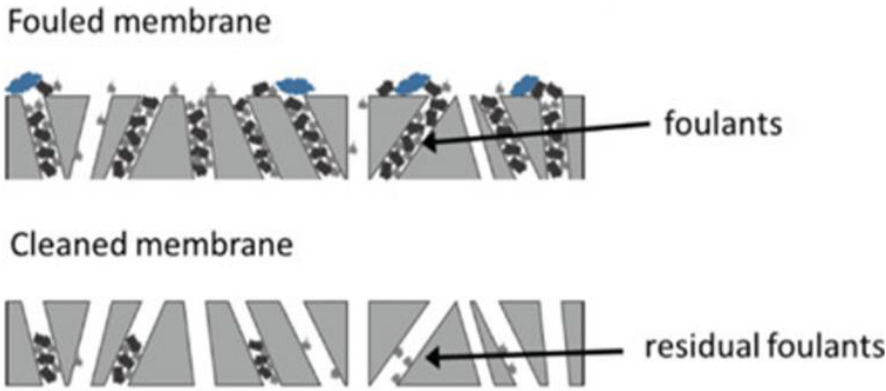
Figure 6. Schematic of a fouled membrane. Reproduced from [76].